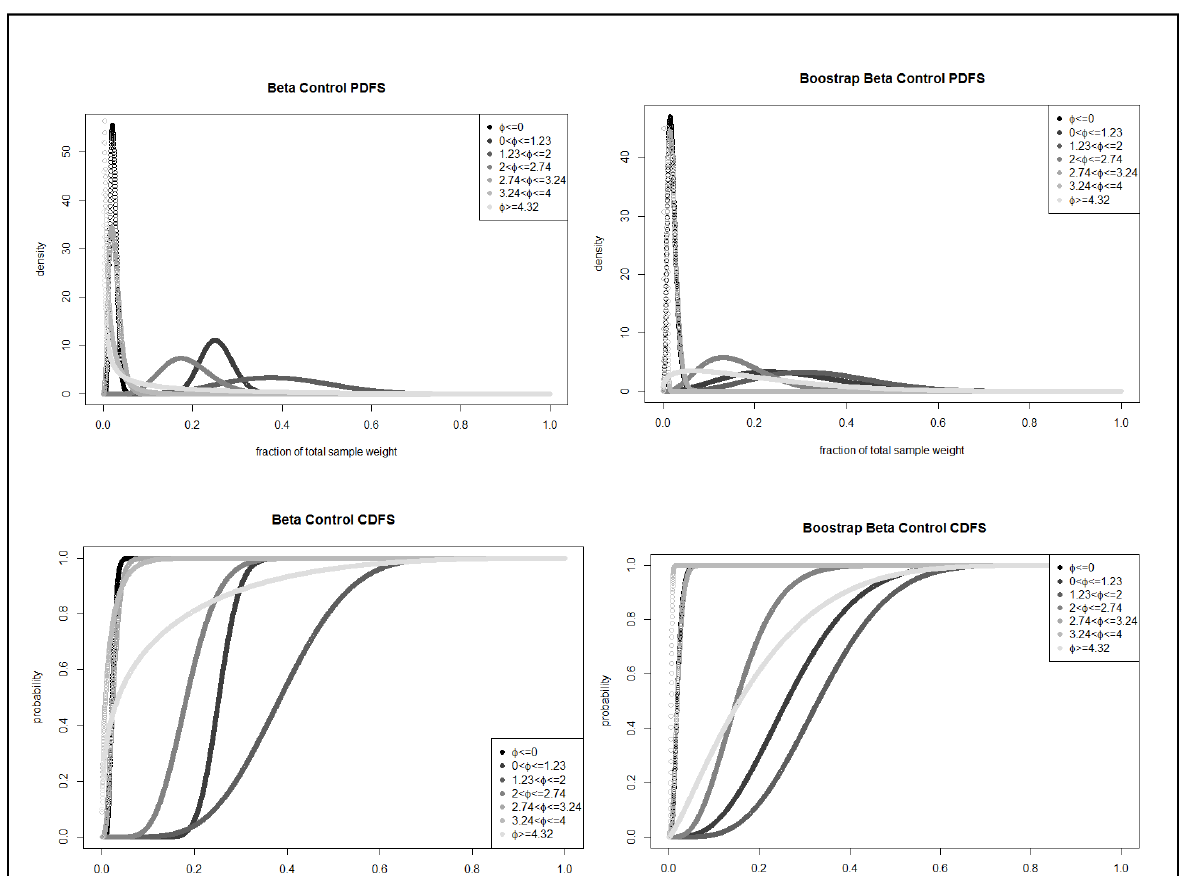
Figure 3. Control test—beta distributions of original samples along with bootstrap distributions.